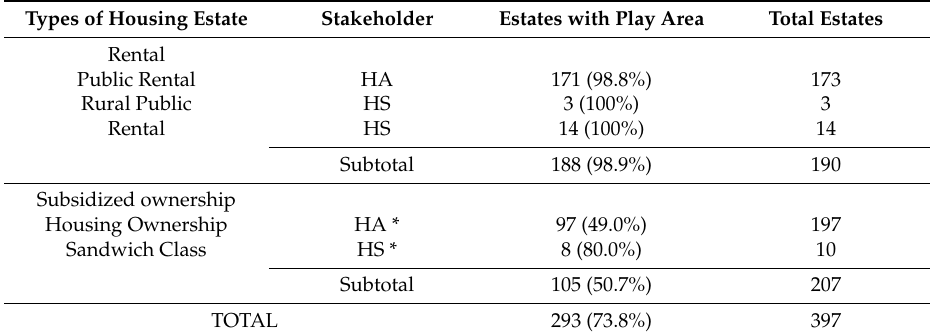
Table 2. Playgrounds managed by housing estates. The statistics are computed based on data retrieved from the GeoInfo Map and websites of HA and HS #.